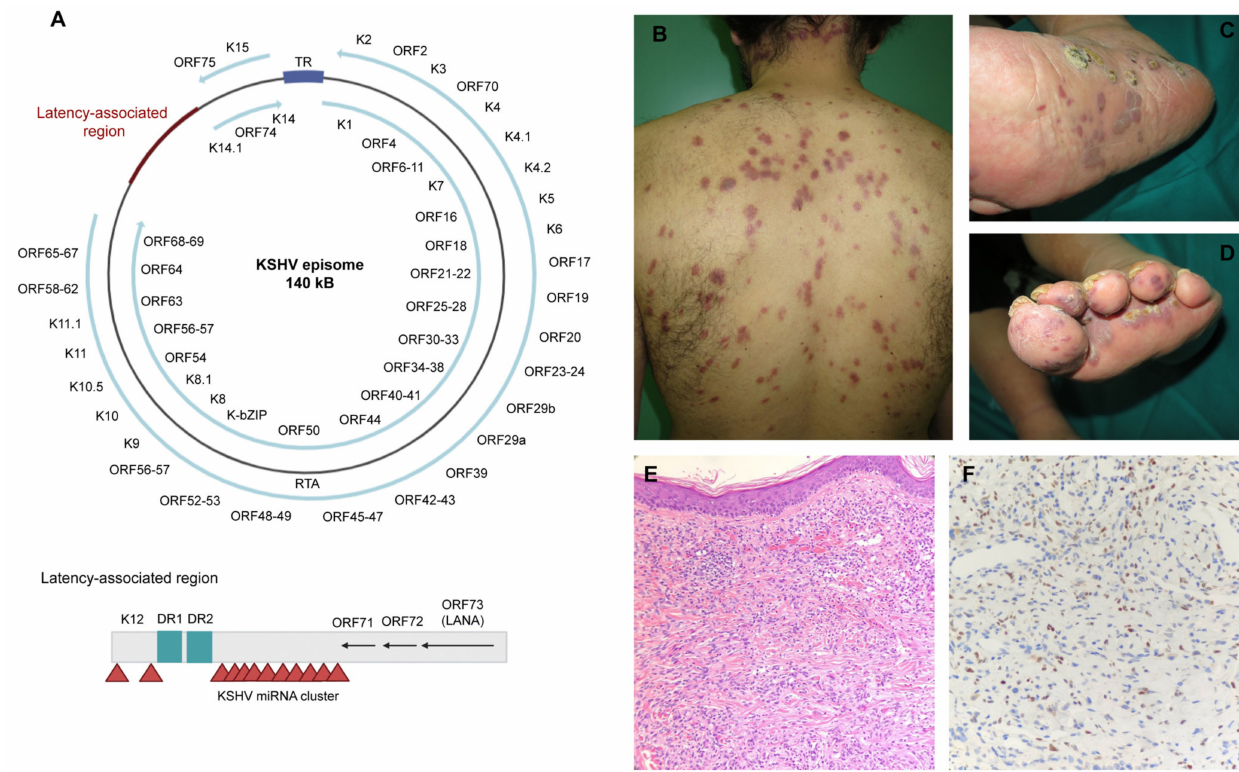
Figure 3. Human herpesvirus 8 and Kaposi’s sarcoma: ( A ) Scheme of HHV8. ( B – D ) The clinical aspect of Kaposi’s sarcoma, consistent with erythematous nodules located in the trunk of an HIV+ male ( B ) and in the foot of an elderly woman ( C , D ). ( E ) The H&E aspect. ( F ) The positive stain for HHV8. All the photographs were generated and provided by the